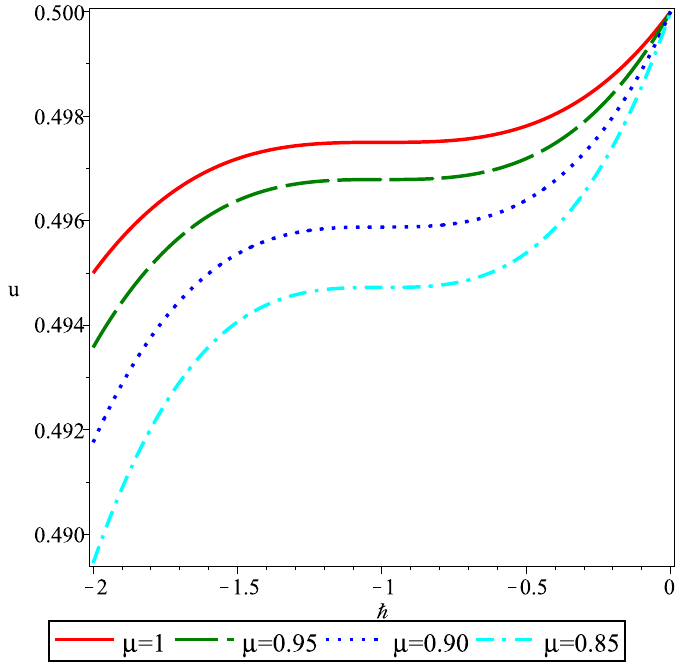
Figure 6. (cid:125)(cid:125)(cid:125) -curve of u ( t ) at t = 0.01 for various values of µ .